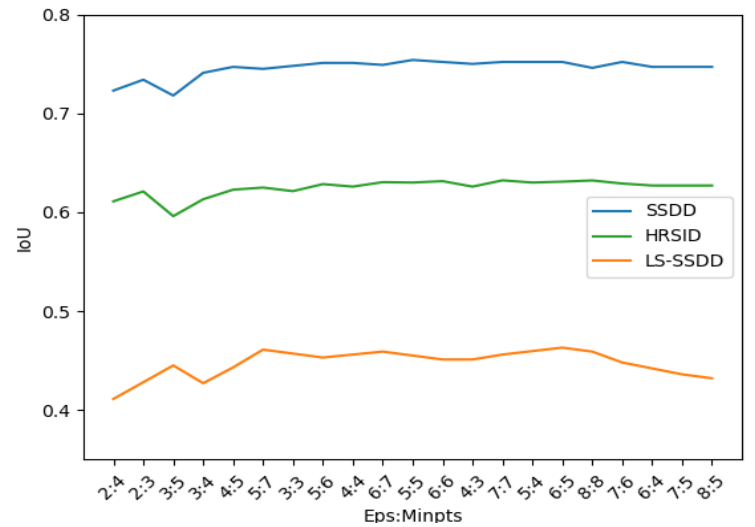
Figure 8. The performance of different Eps and MinPts on SSDD and HRSID. The vertical coordinate is the value of IoU and the horizontal coordinate is Eps : MinPts .